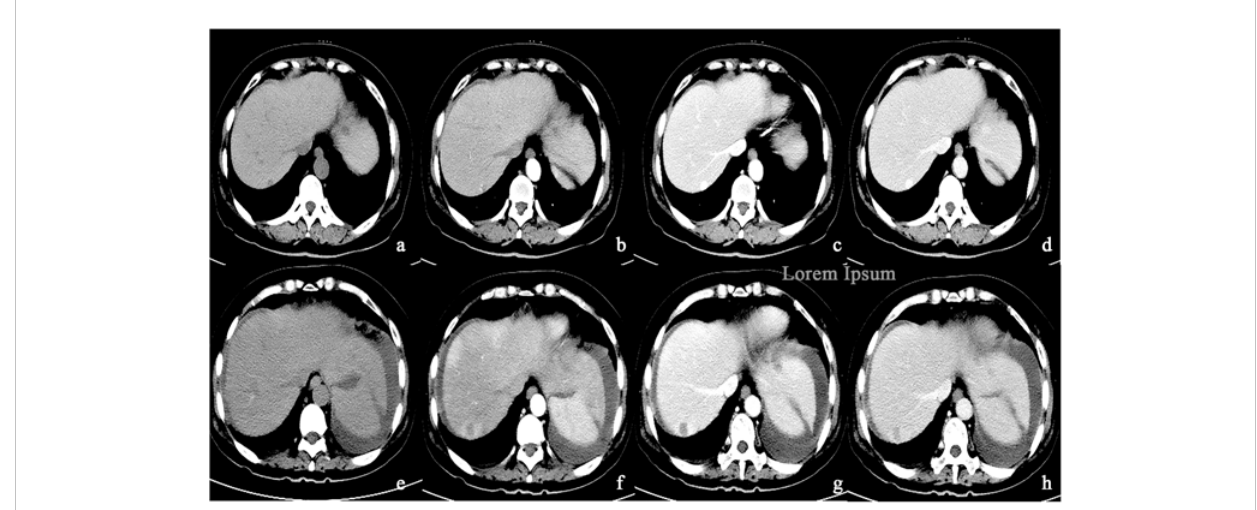
FIGURE 5 (A – D) A round low-density mass in the right lobe of the liver was shown in the plain CT. The lesions demonstrate peripheral nodular discontinuous enhancement in the arterial phase and centripetal fi lling in the portal and delayed phases. (E – H) After treatment with Bevacizumab, the lesions showed circular